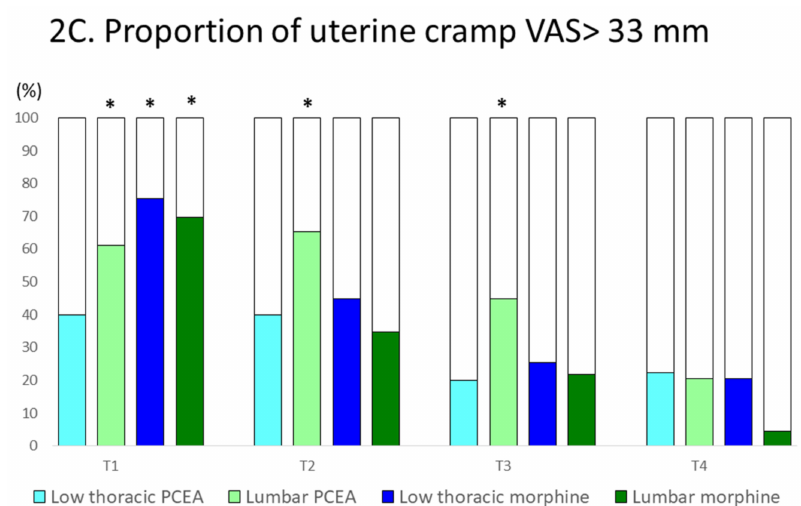
Figure 2. ( A ) Proportion of participants with a visual analog scale score of >33 mm of static wound pain. * means a p value < 0.05 compared to that of the low thoracic PCEA group. ( B ) Proportion of participants with a visual analog scale score of >33 mm of dynamic wound pain. * means a p value < 0.05 compared to that of the low thoracic PCEA group. ( C ) Proportion of participants with a visual analog scale score of >33 mm of uterine cramp. * means a p value < 0.05 compared to that of the low thoracic PCEA